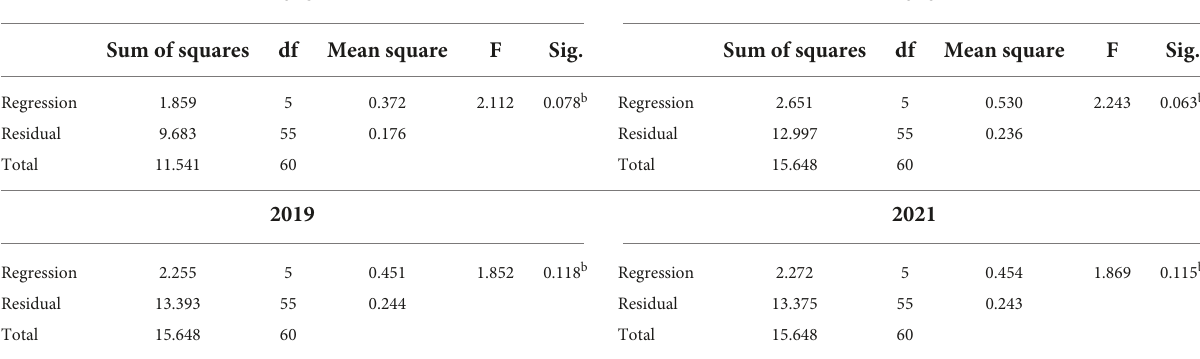
TABLE 3 ANOVA (main